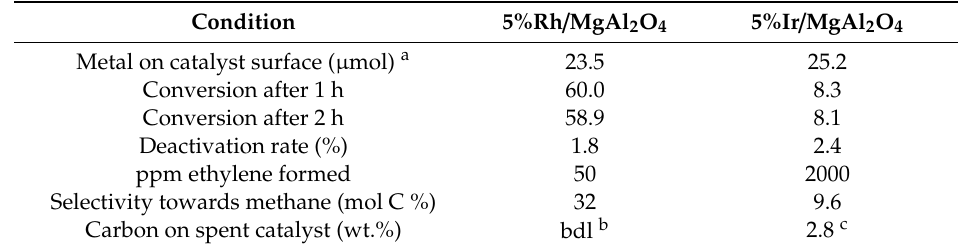
Table 2. Catalytic results for ethane steam reforming over MgAl 2 O 4 -supported Rh and Ir catalysts at 600 ◦ C (S / C = 2.75 mol, τ = 28.3